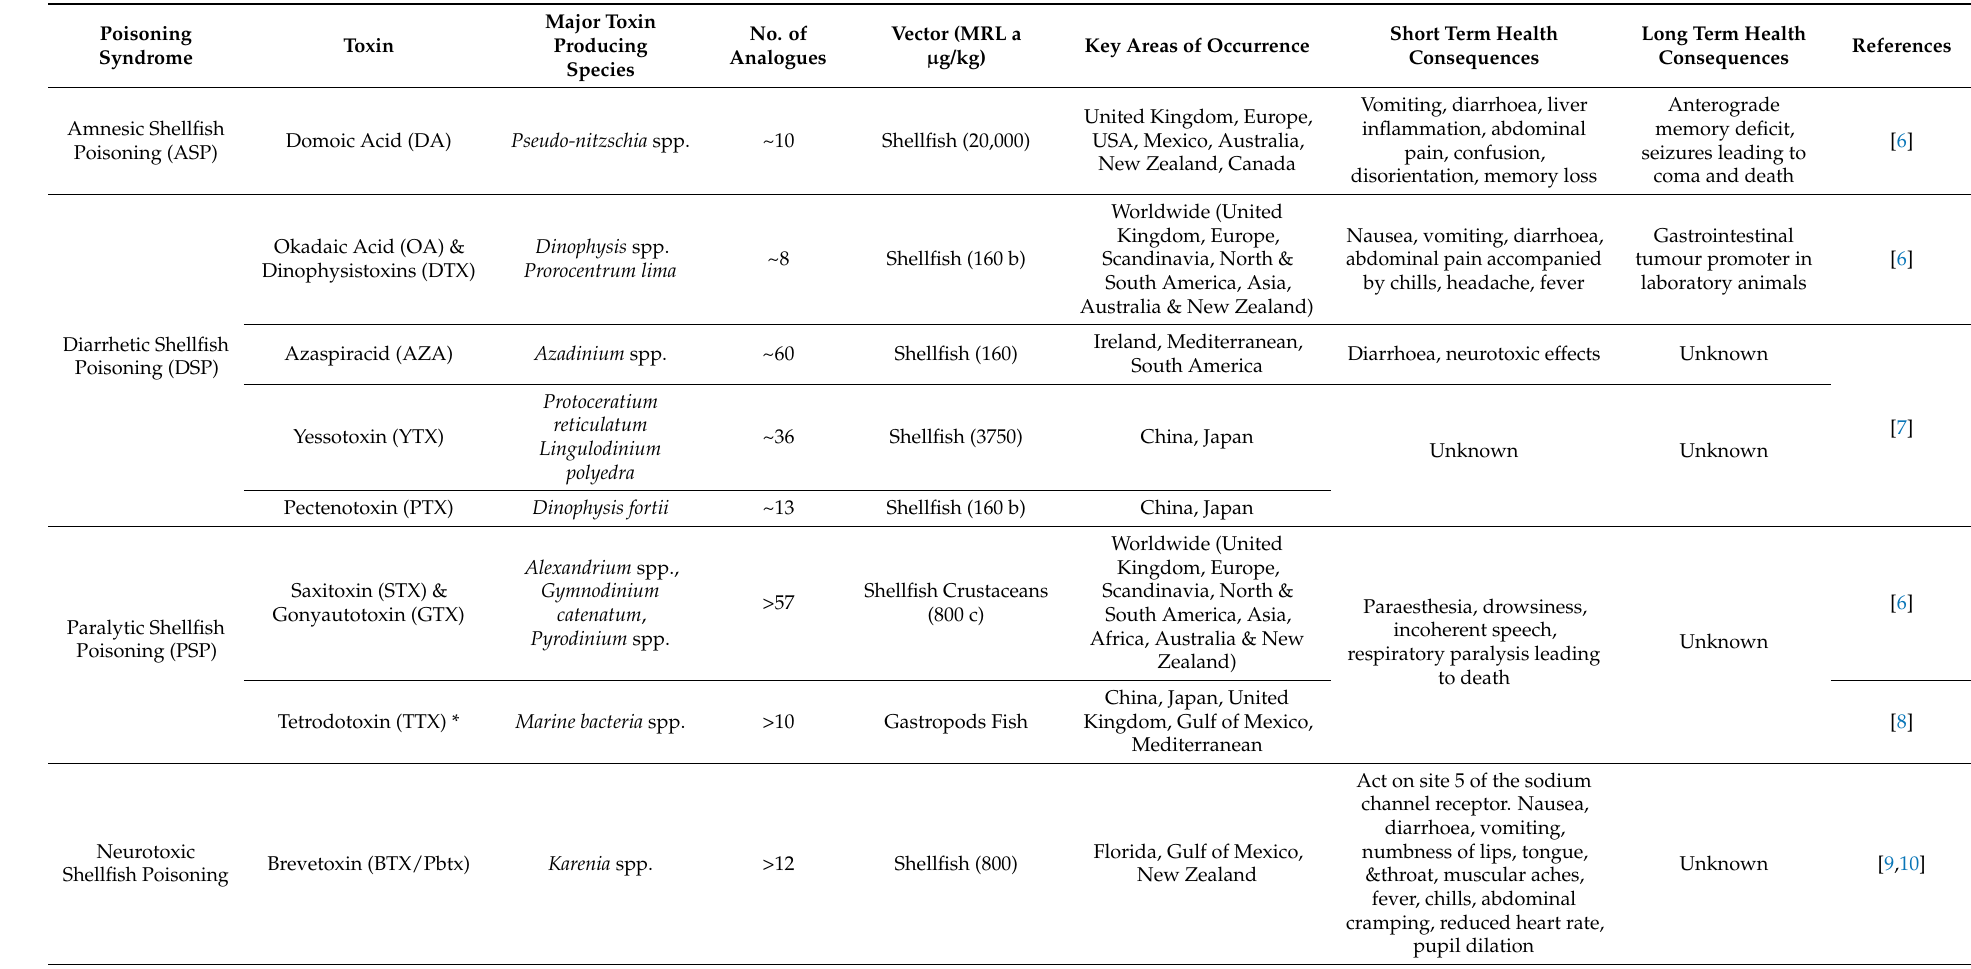
Table 1. Major shellfish poisoning syndromes showing causative toxins, vectors, and associated health risks to